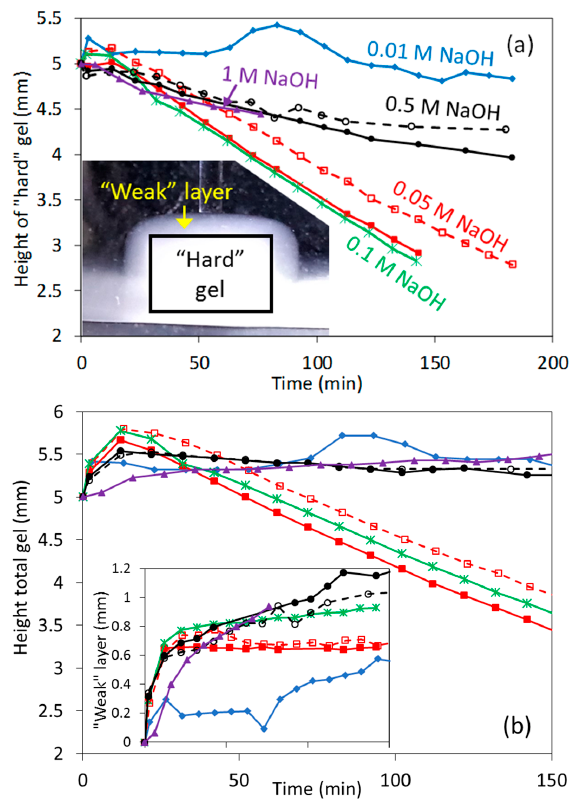
Figure 8. ( a ) Estimated height of the mechanically responsive gels (“hard” gels) at high (NaOH). Inset shows an example of the “weak” protein layer that forms during dissolution; ( b ) total height of gels from side microscopy measurements, including the “weak” layer shown in the inset. Empty points and dashed lines are used for repeated experiments.